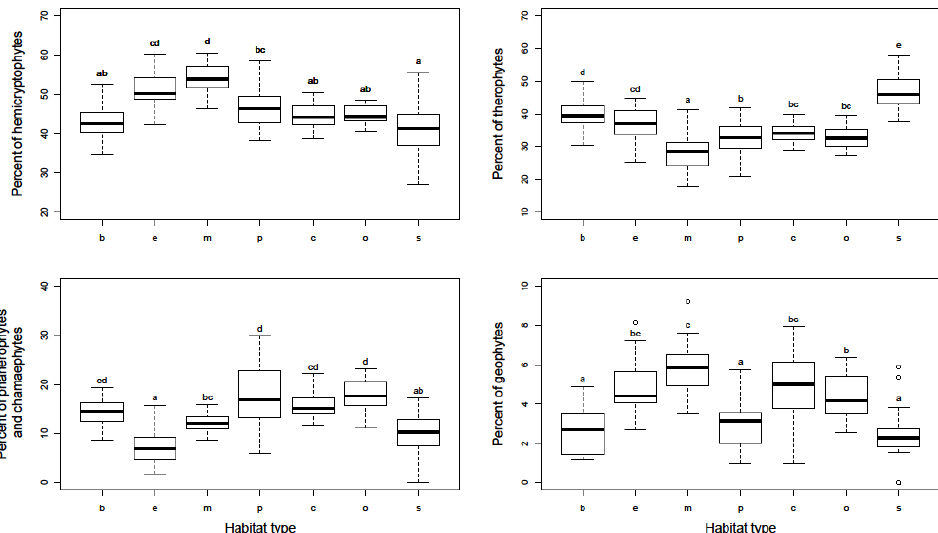
Figure 1. Proportion of hemicryptophytes, therophytes, phanerophytes/chamaephytes, and geo-